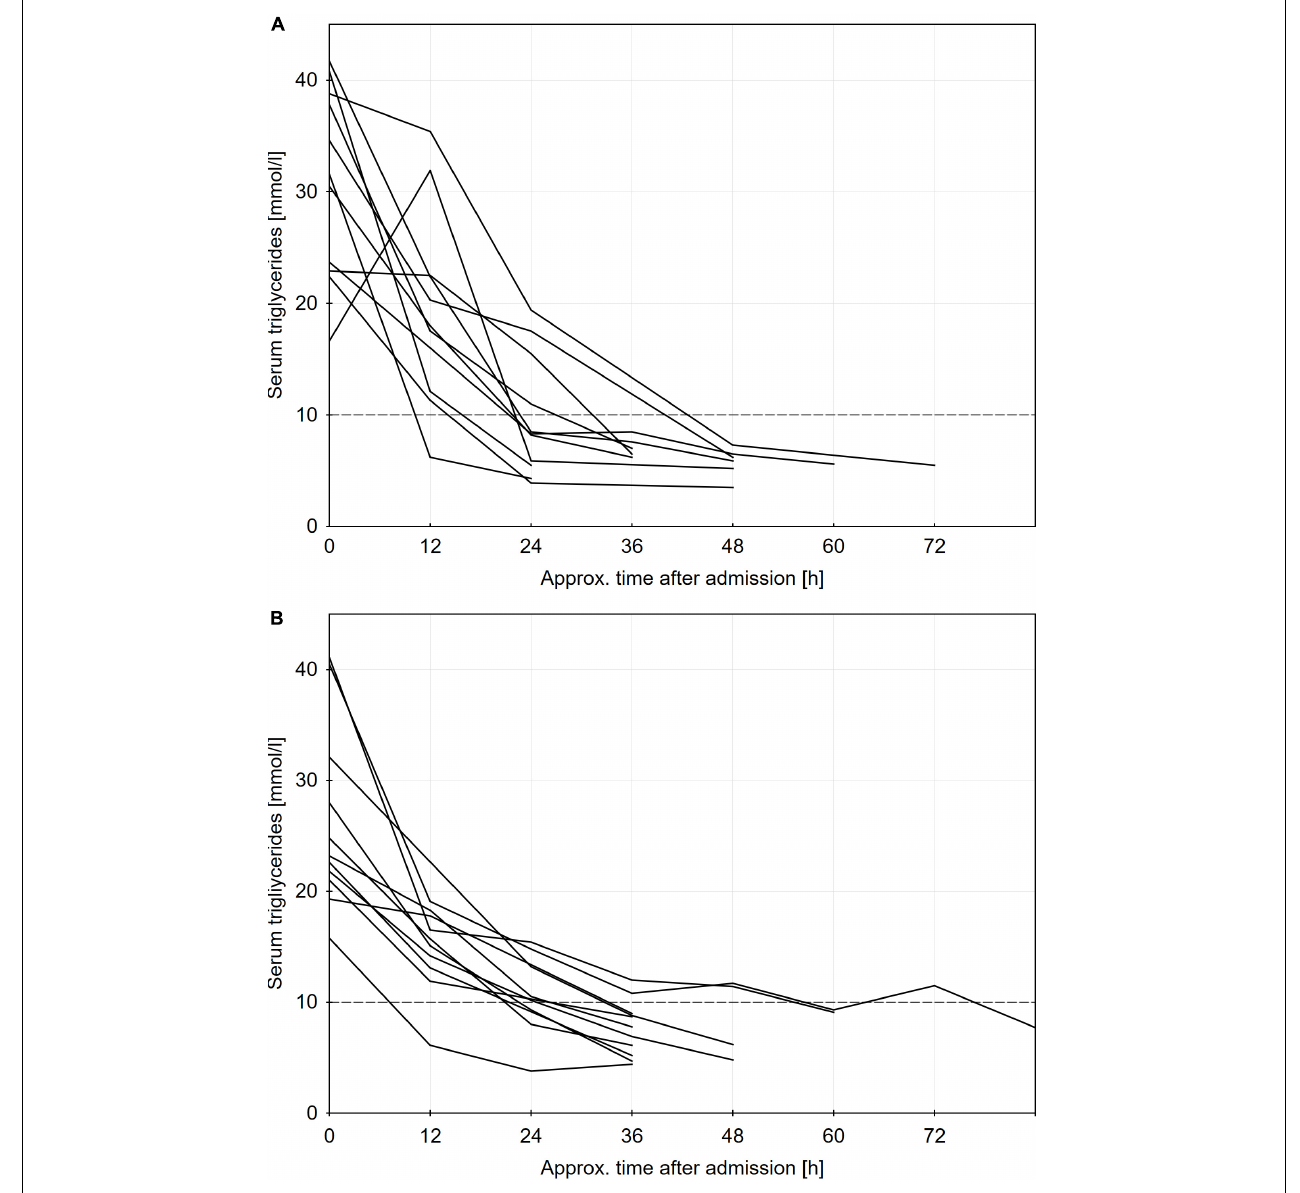
FIGURE 2 | Individual patients triglycerides profiles for plasma exchange panel (A) and insulin panel (B) groups. To convert TG units to mg/dL, multiply by